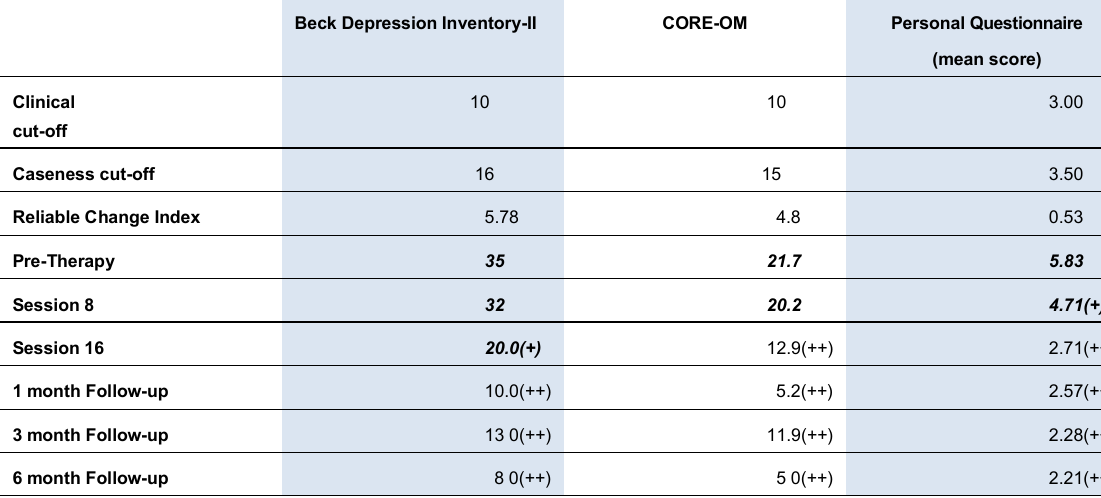
Table 1. Peter’s Outcome